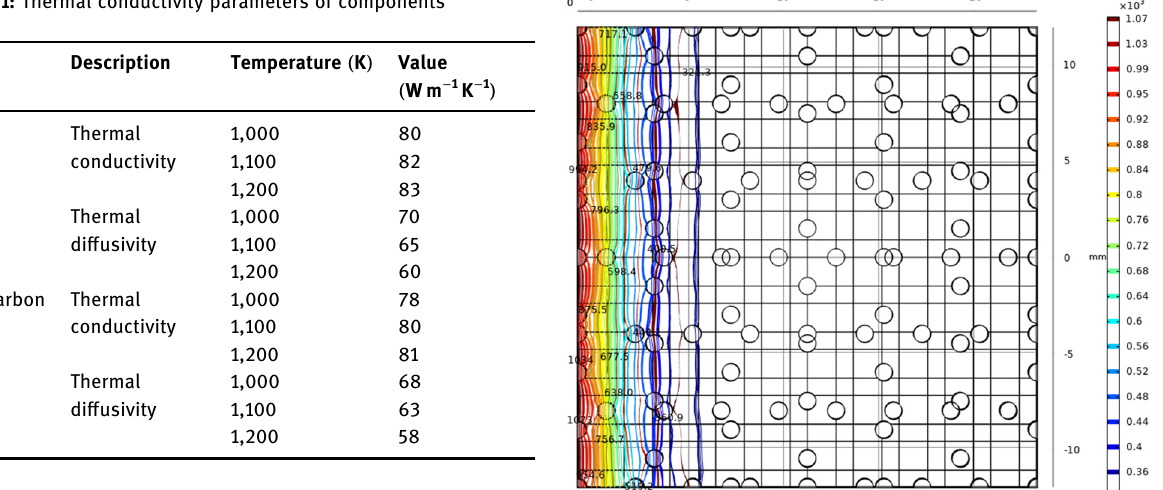
Table 1: Thermal conductivity parameters of components